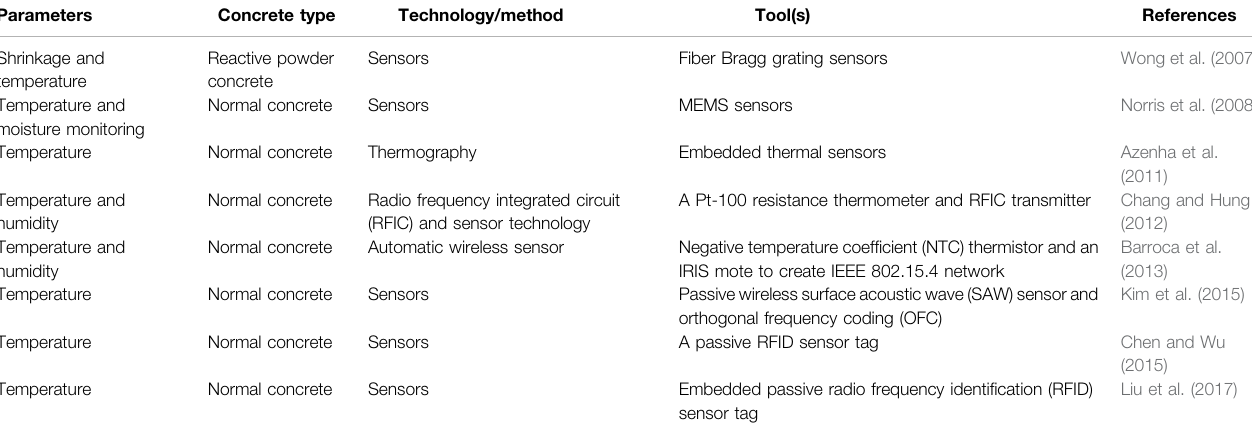
TABLE 4 | Digital transformation of concrete temperature monitoring.